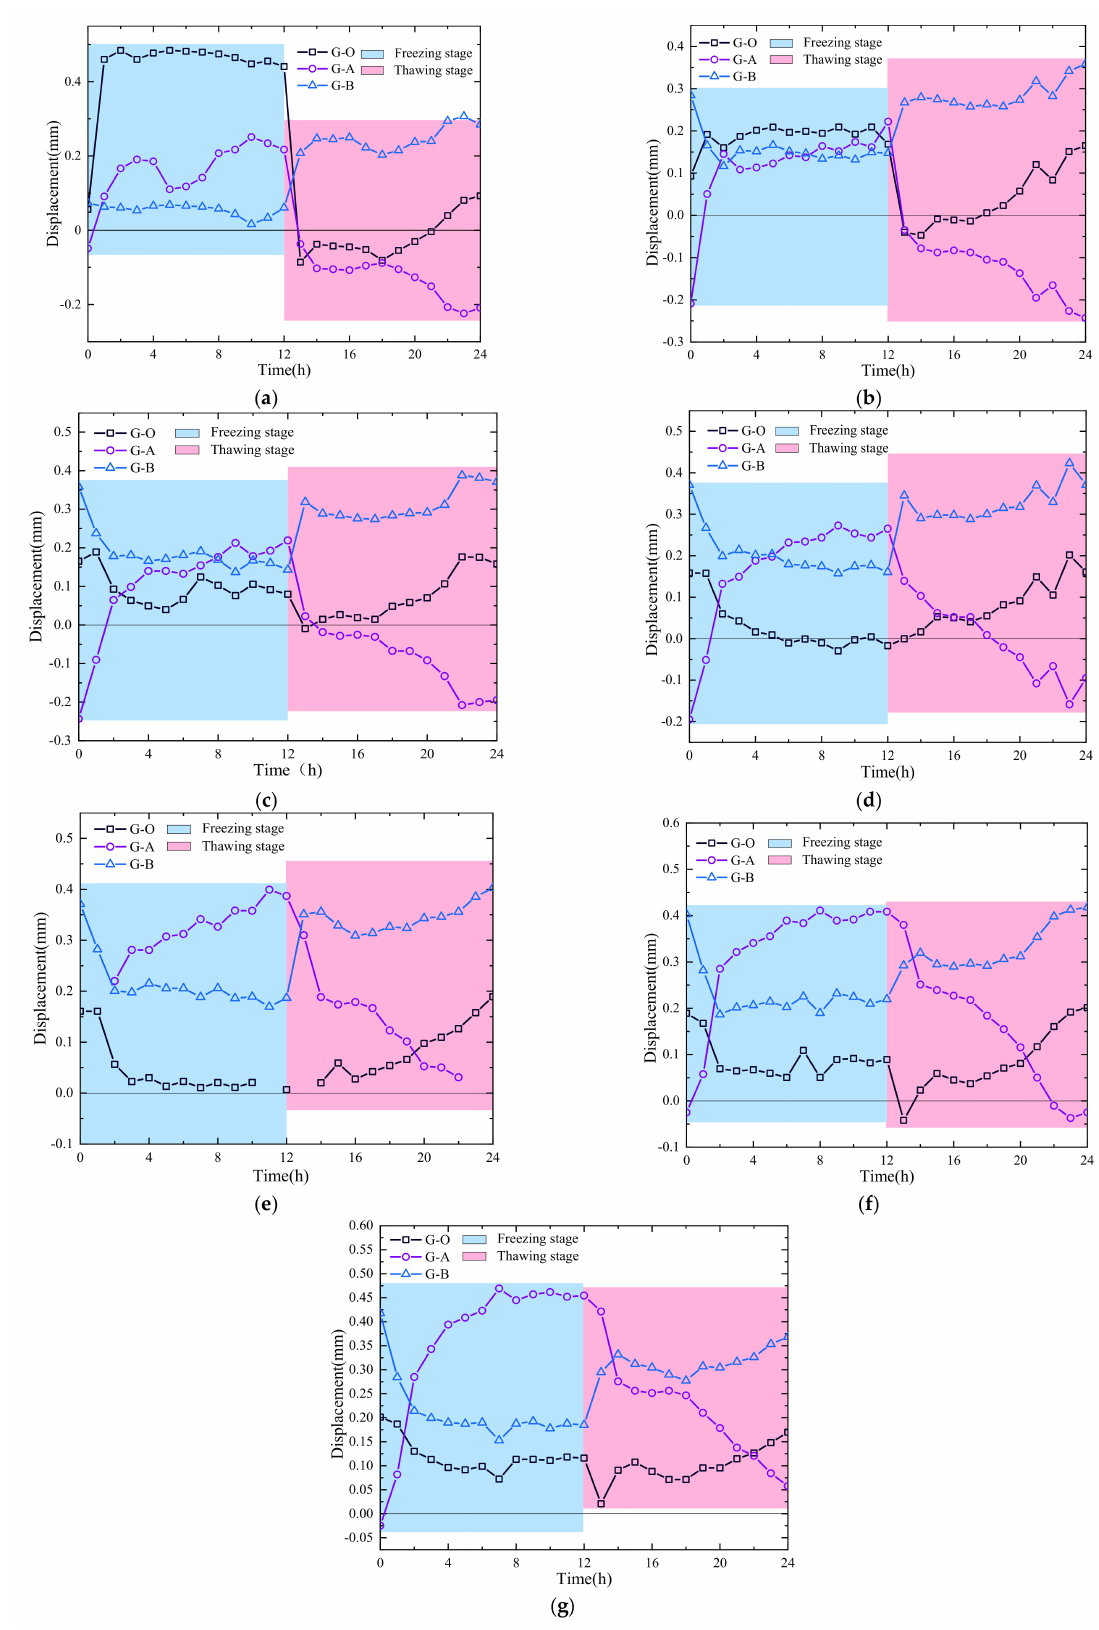
Figure 7. Displacement deformation under different freeze–thaw cycles: ( a ) freeze–thaw cycle once ( b ) freeze–thaw cycles two times ( c ) freeze–thaw cycles three times ( d ) freeze–thaw cycles four times ( e ) freeze–thaw cycles five times ( f ) freeze–thaw cycles six times ( g ) freeze–thaw cycles seven